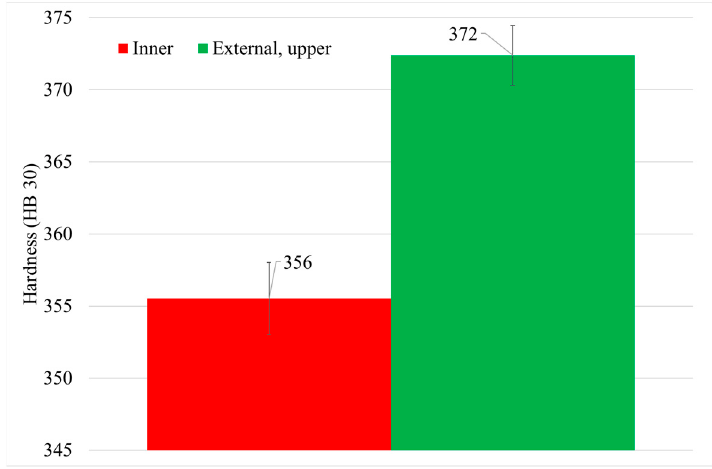
Figure 9. Hardness values in the inner and external part of the can.